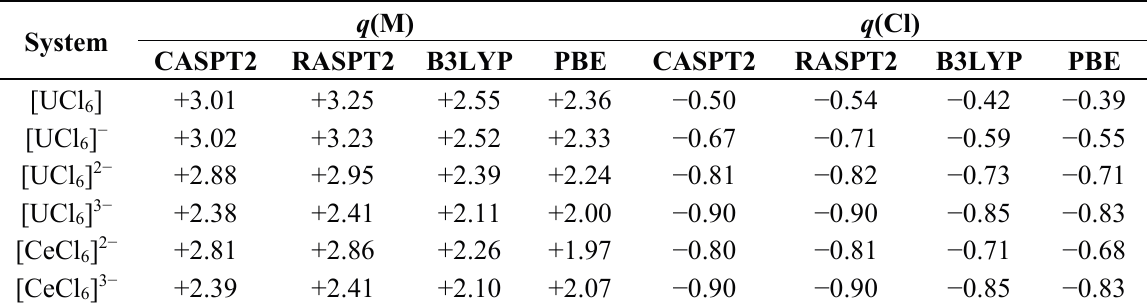
Table 5. QTAIM derived atomic charges of metal hexachlorides, evaluated at theoretically optimised geometries. All values are in a.u.